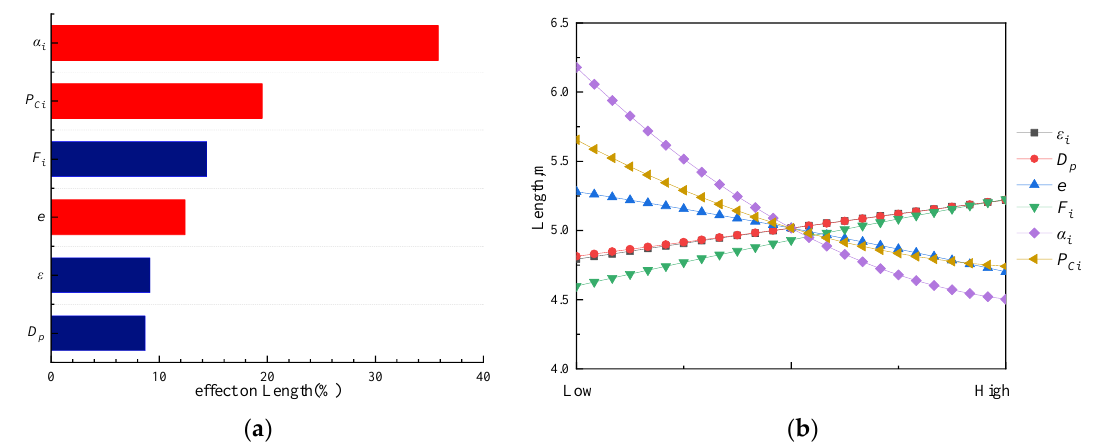
Figure 20. Parametric analysis of design variables to the motor length. ( a ) Pareto diagram; ( b ) main effect plot.